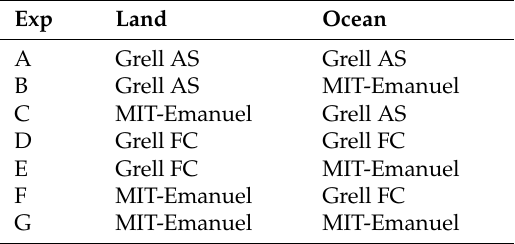
Table 1. Summary of Regional Climate Model version 4 (RegCM4.4) simulations done to test the performance of the different cumulus schemes over the region. The Land/Ocean indicate which schemes were used over land/ocean in the simulation. AS is the Arakawa–Schubert closure for Grell, FC–Fritsch–Chappell, and MIT–Massachusetts Institute of Technology. Exp Land Ocean A Grell